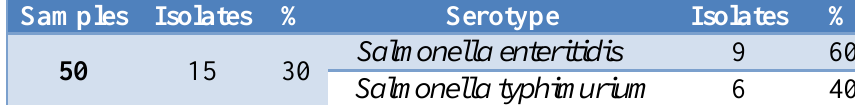
Table, 1: The serotypes which isolated and it’s